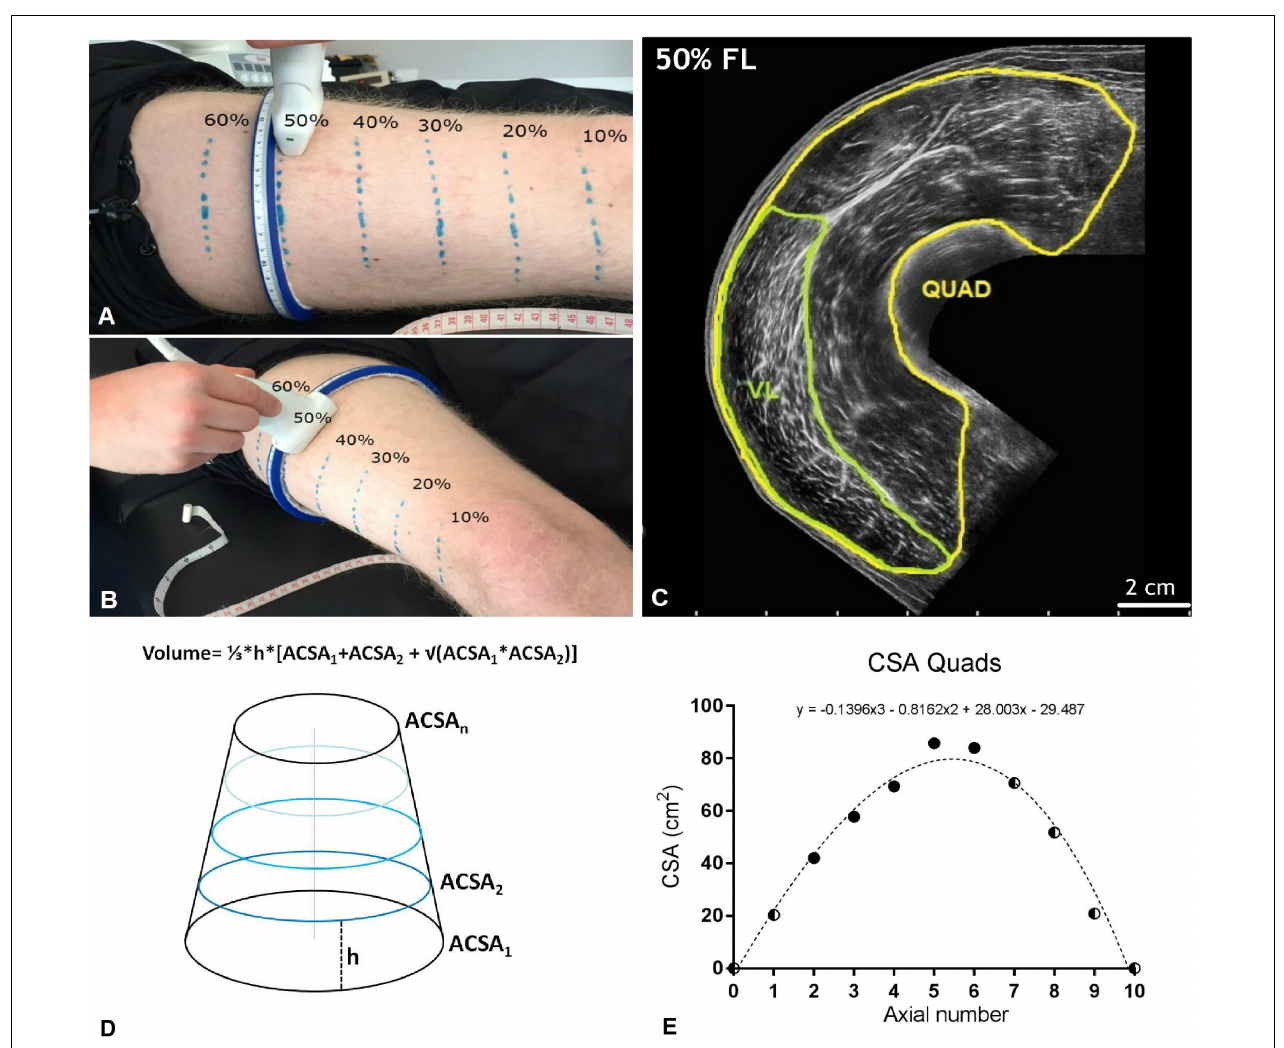
FIGURE 2 | (A,B) Ulatrsonographic assessment of quadriceps femoris (QF) cross-sectional area (CSA) at different percentages of the femur length (measured from the great throcanter to the mid-patellar point). Region of interests considered were 20, 30, 40, 50, and 60% of the femur length. (C) Quad and vastus lateralis (VL) CSA obtained at the 50% of the femur length from a representative subject. (D) Truncated cone formula. The muscle volume between each couple of contiguos √ axials was calculated as 1/3*h*[ACSA 1 + ACSA 2 + (ACSA 1 *ACSA 2 )], where ACSA stands for anatomical cross-sectional area. (E) Mathematical estimation of the lacking Quad CSA (10, 70, 80, and 90% of the femur length). A third order polynomial curve (reported for a representative subject) was fitted through the CSA values that were truly measured. For simplicity, the CSA values corresponding to the 0% and the 100% of the femur length were set as 0. Half and half symbols represent the estimated